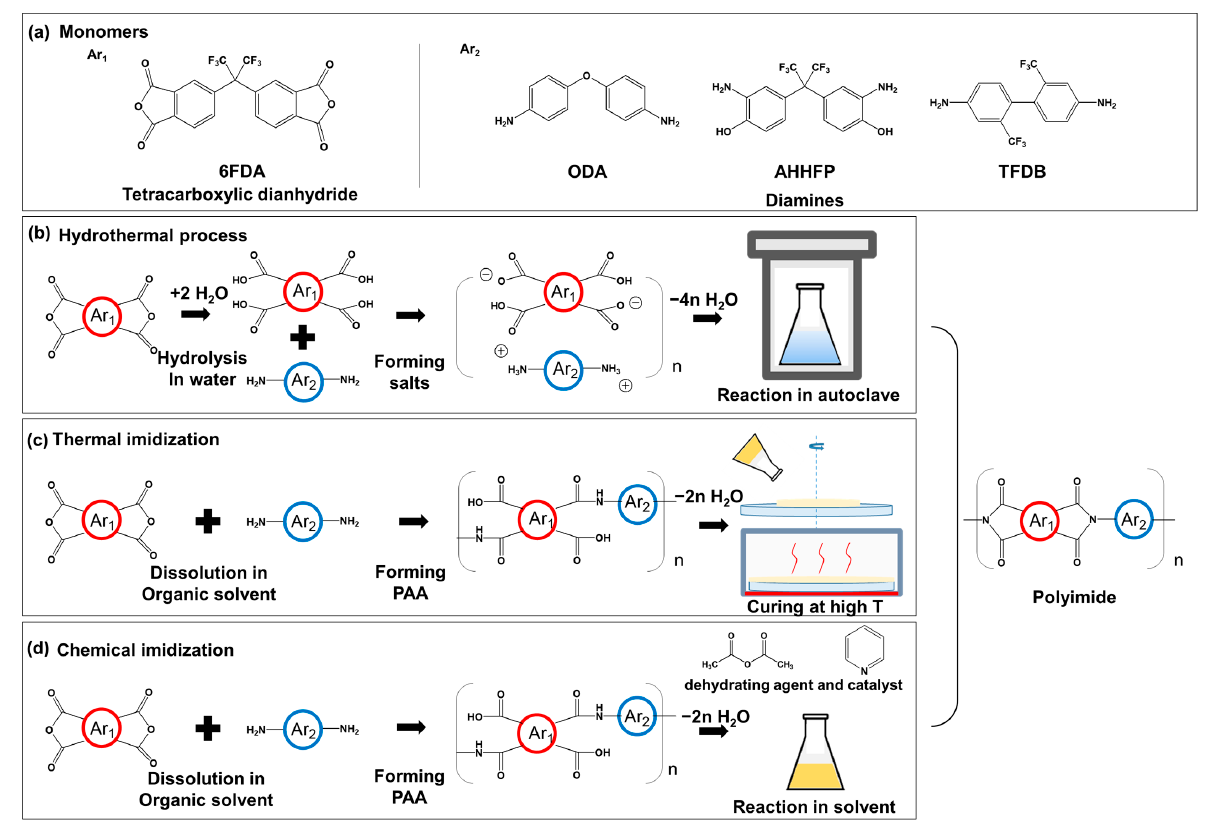
Figure 1. ( a ) monomers for fluorinated polyimides and synthetic pathways of polyimide, ( b ) hydrothermal process, ( c ) thermal imidization, ( d ) chemical imidization.